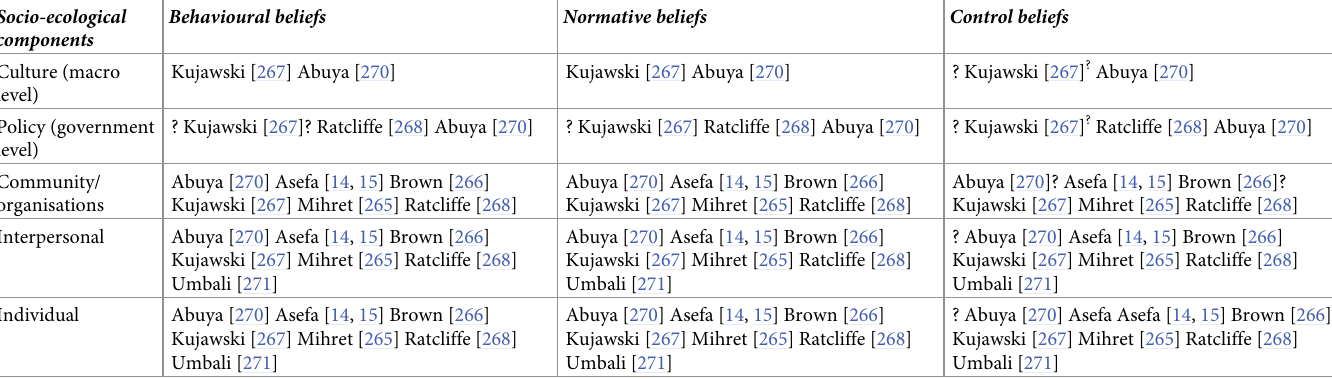
Table 7. Mapping published studies of respectful care interventions in maternity services to the proposed socio-ecological-behavioural approach. Socio-ecological components